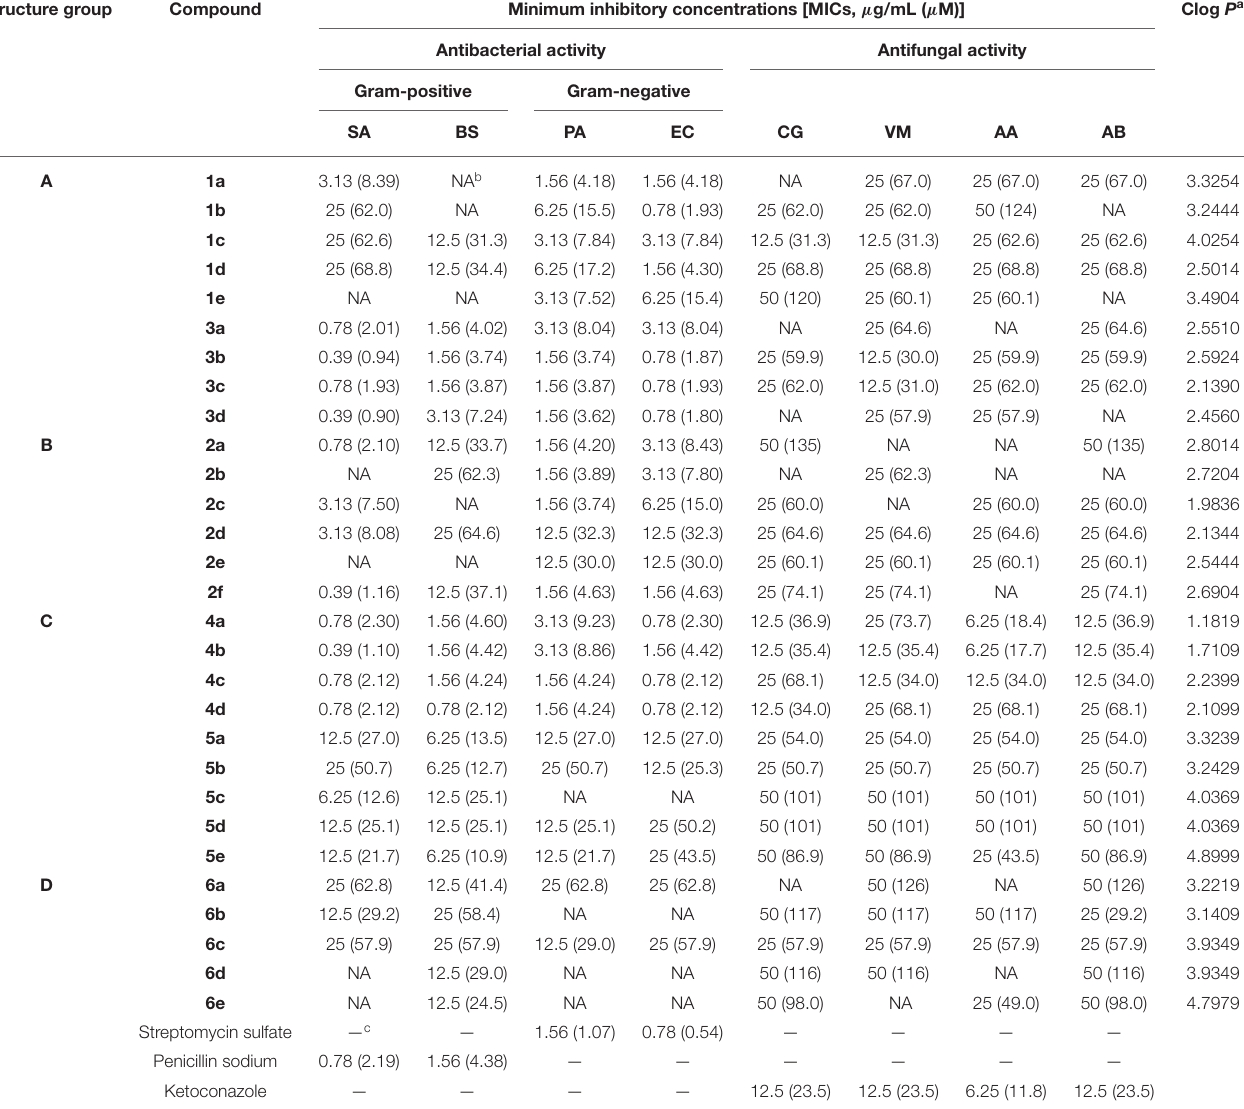
TABLE 1 | Antimicrobial Activity of the Four Structure Groups against tested bacteria and plant pathogenic fungi. Structure